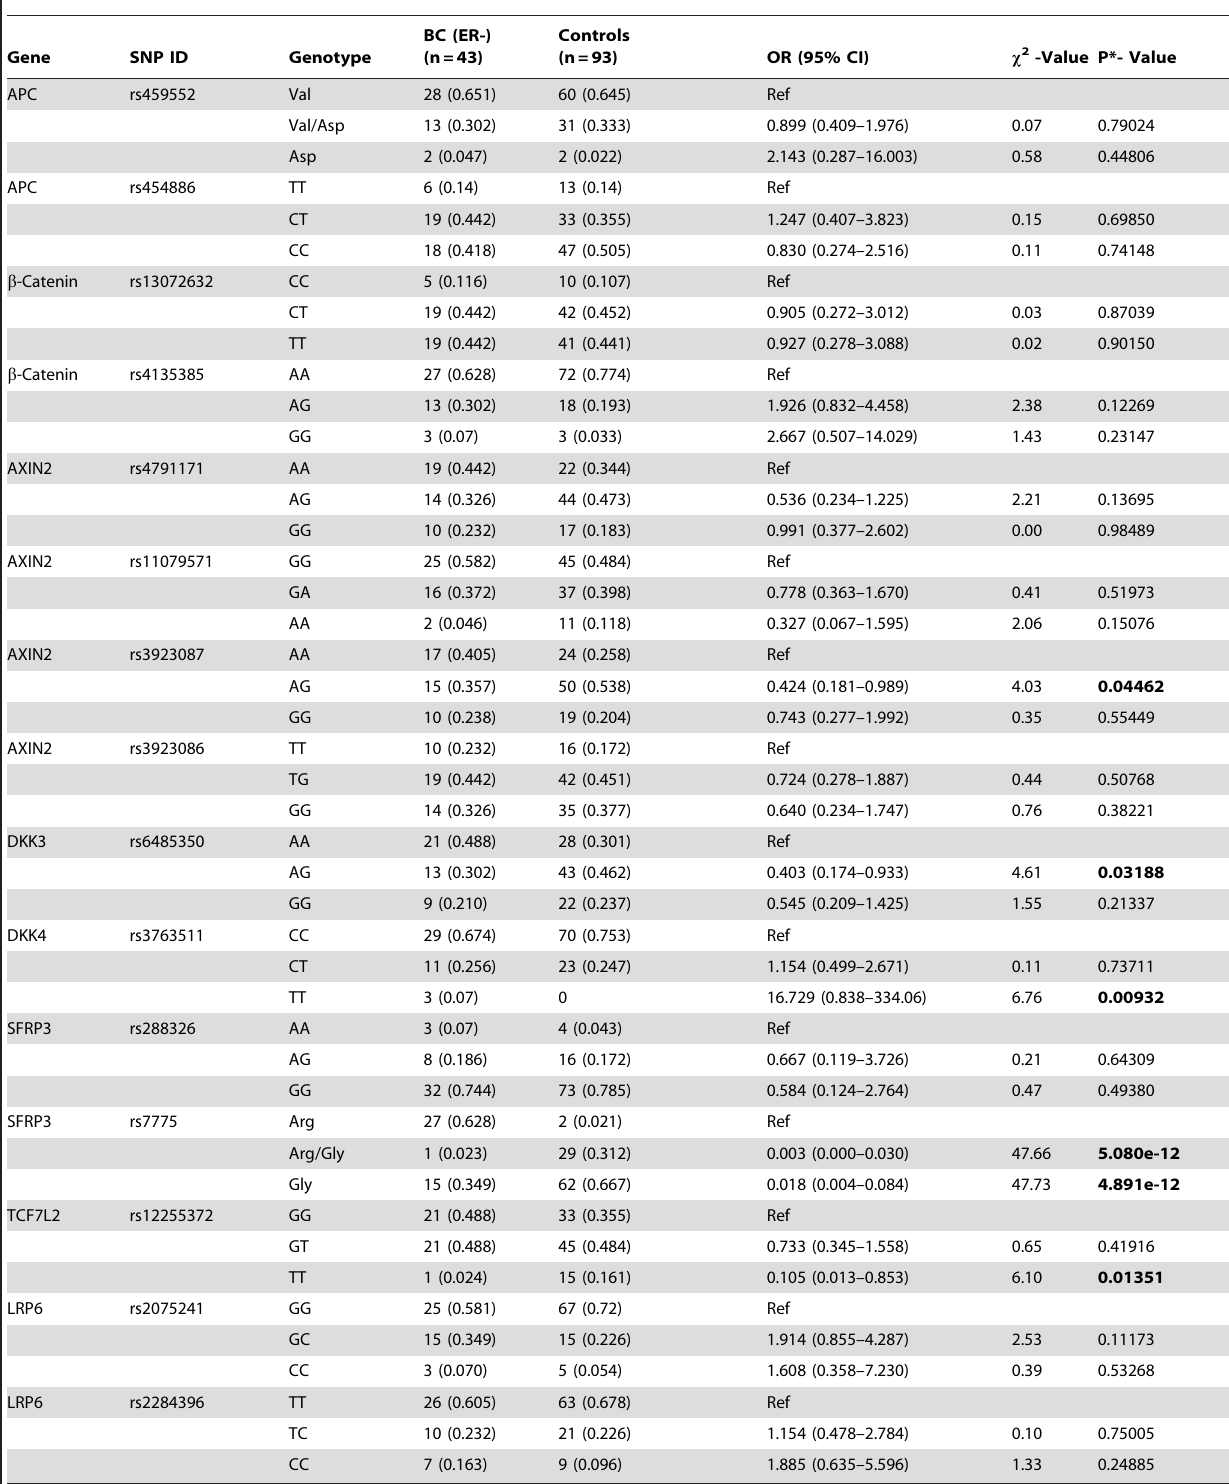
Table 6. Comparison of genotype frequencies of SNPs in Wnt pathway genes between ER- breast cancers versus controls.